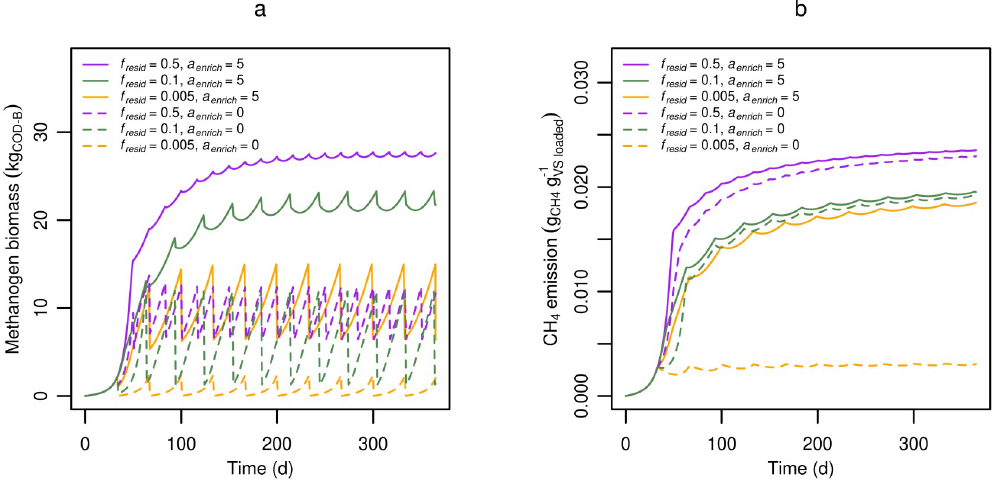
Fig 5. Predicted effects of residual slurry fraction on methanogens and methane production. (a) Total methanogen biomass and (b) Cumulative CH 4 emission as affected by the residual fraction ( f resid ) of slurry after slurry removal assuming a high degree of microbial enrichment ( a ), or no enrich